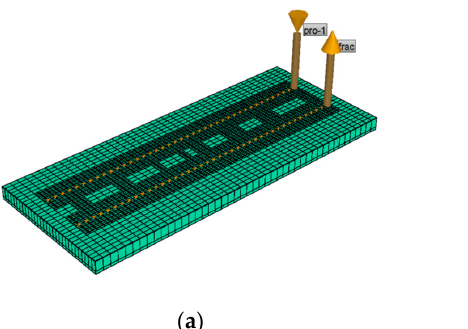
Figure 9. Water saturation distribution of multi-well system. ( a ) Fracture connectivity of 40%. ( b ) Fracture connectivity of 80%.